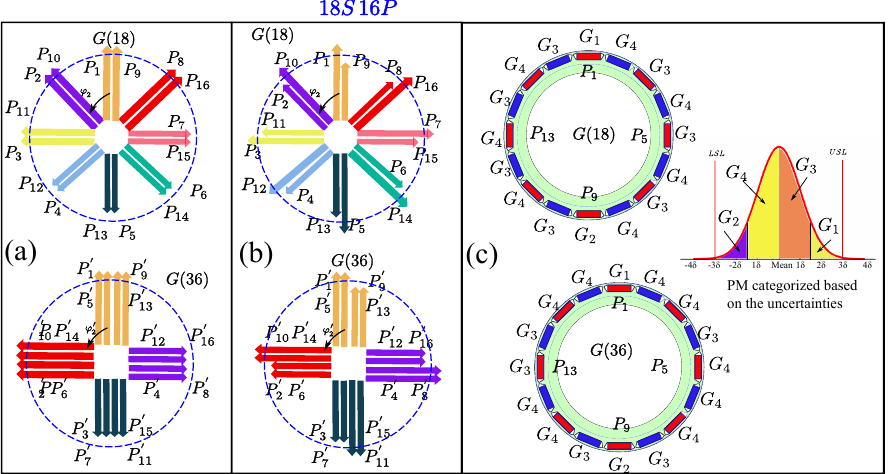
Figure 16. Apply PM assembling approach for 18S16P configuration. ( a ) The vector diagram for the worst-case combinations of uncertainties, ( b ) the vector diagram for the proposed PM assembling approach combinations, ( c ) the PM categorized and assembling approach considering the 18th and 36th order of cogging torque harmonics.